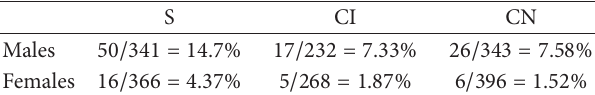
Table 1: Percent of uninfected progeny by sex and selective regime. Selective regimes included the following: S (resistance to B. cereus infected), CI (response to wounding), and CN (the unperturbed control). Percent was calculated as the total number of uninfected progeny divided by total number of progeny.